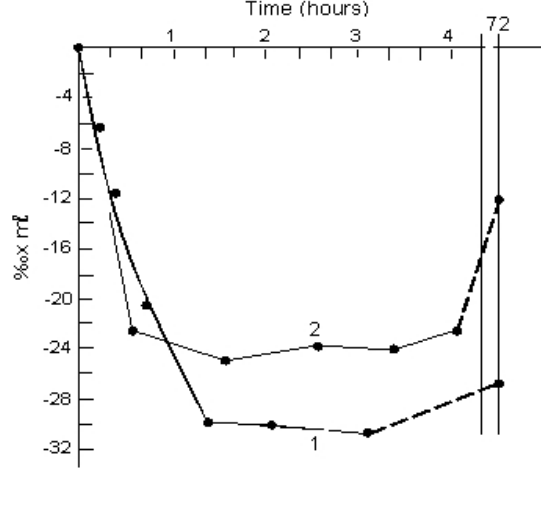
Fig. 12 Exiting of oxygen isotopes from the membrane after experiments with a tem- perature gradient and countercurrent flow. The comparison between short and extended experiments. Change of isotope quantity ( (cid:2) × ml) in water above the membrane over time. Curve 1- short experiment (5 h) fig. 8. According to isotope balance calculation after this experiment there remains in the membrane an excess of light isotopes 36.5 (cid:2) × ml. Curve 2 - extended experiment (24 h) fig. 10, an excess of light isotopes 20.3 (cid:2) ×